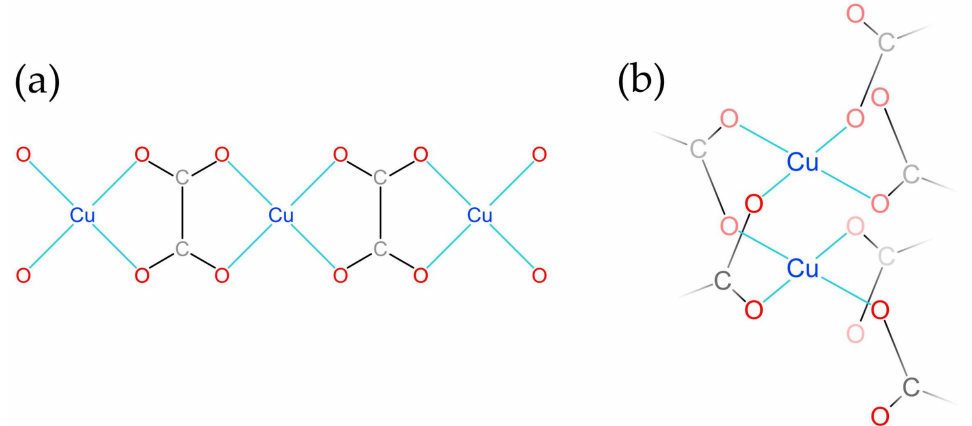
Figure 1. Fragments of two possible crystal structures of copper oxalate proposed by Dubicki et al.